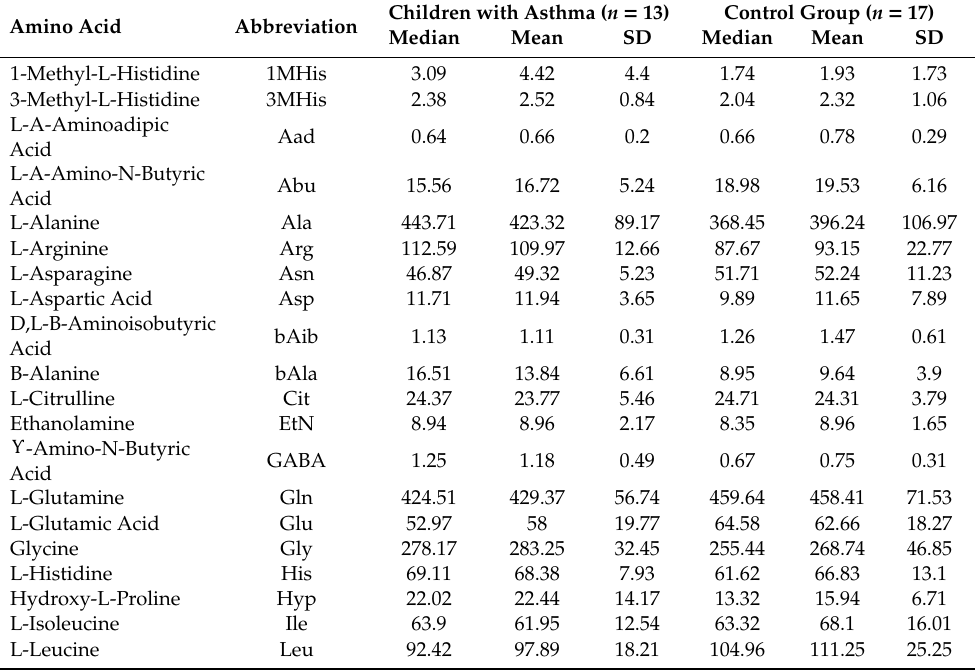
Table 2. The determined concentrations of 32 amino acids in serum samples collected from children with asthma and the control group. Concentration values are given in µ M.